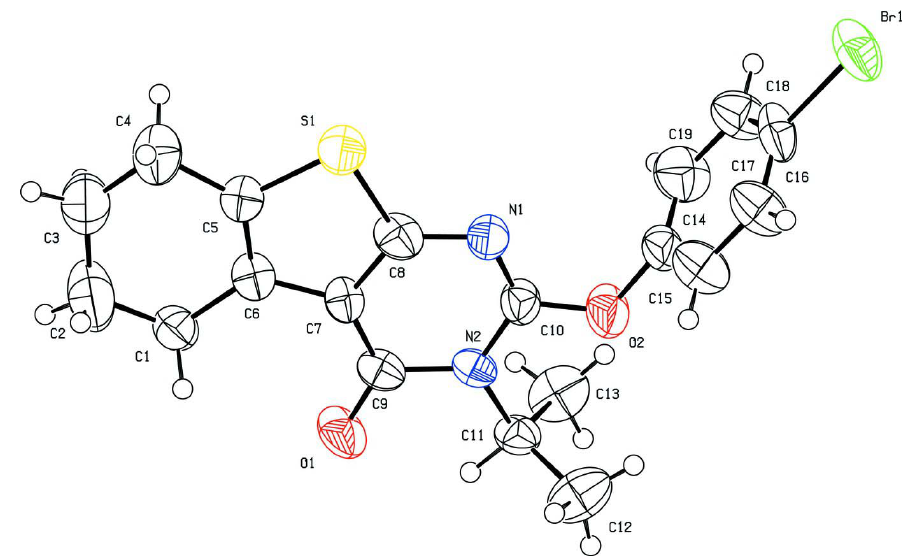
Figure 1 View of the molecule of (I) showing the atom-labeling scheme. Displacement ellipsoids are drawn at 50% probability level. H-atoms are represented by circles of arbitrary